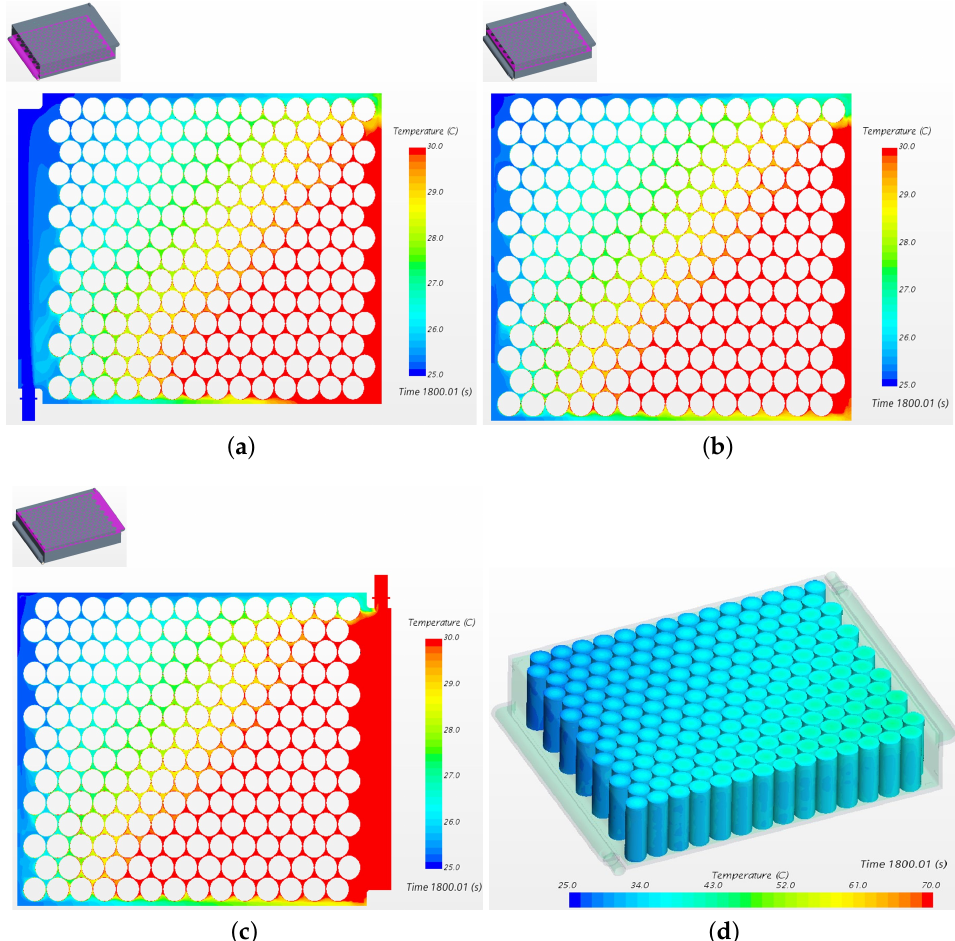
Figure 6. Contours of temperature in (°C) along the cross-sectional vertical plane at Z-height of ( a ) 12mm, ( b ) 35mm, and ( c ) 52mm of the immersion-cooled module. In ( d ), temperature distribution of Li-ion cells within the cold-plate-cooled battery module is shown.